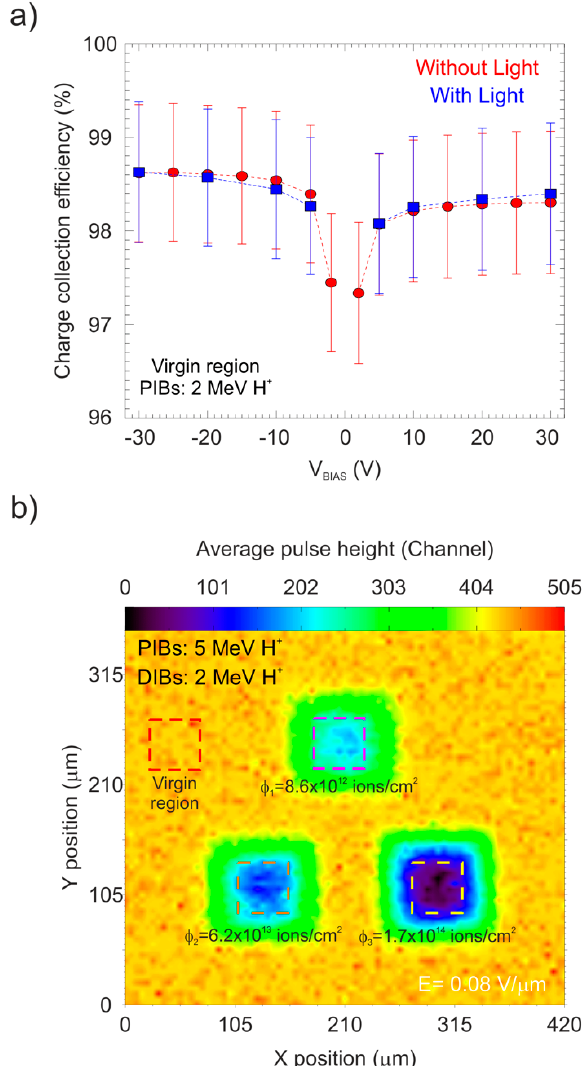
Figure 12. ( a ) CCE as a function of the applied bias for the pristine region of the 65 µ m detector with (blue) and without (red) illumination; ( b ) IBIC map of the detector biased at +6 V (E = 0.09 V/ µ m) obtained using a 2 MeV proton beam showing the selected ROIs.